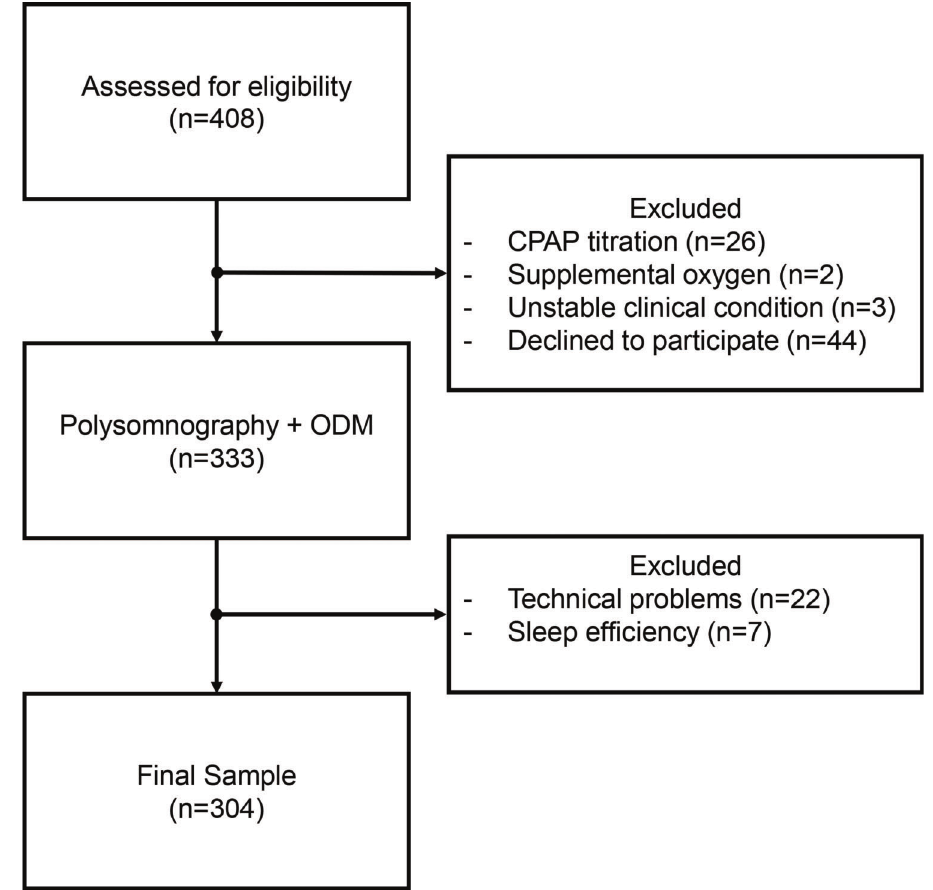
Figure 1 - Flow diagram of the participant recruitment process. ODM=overnight digital